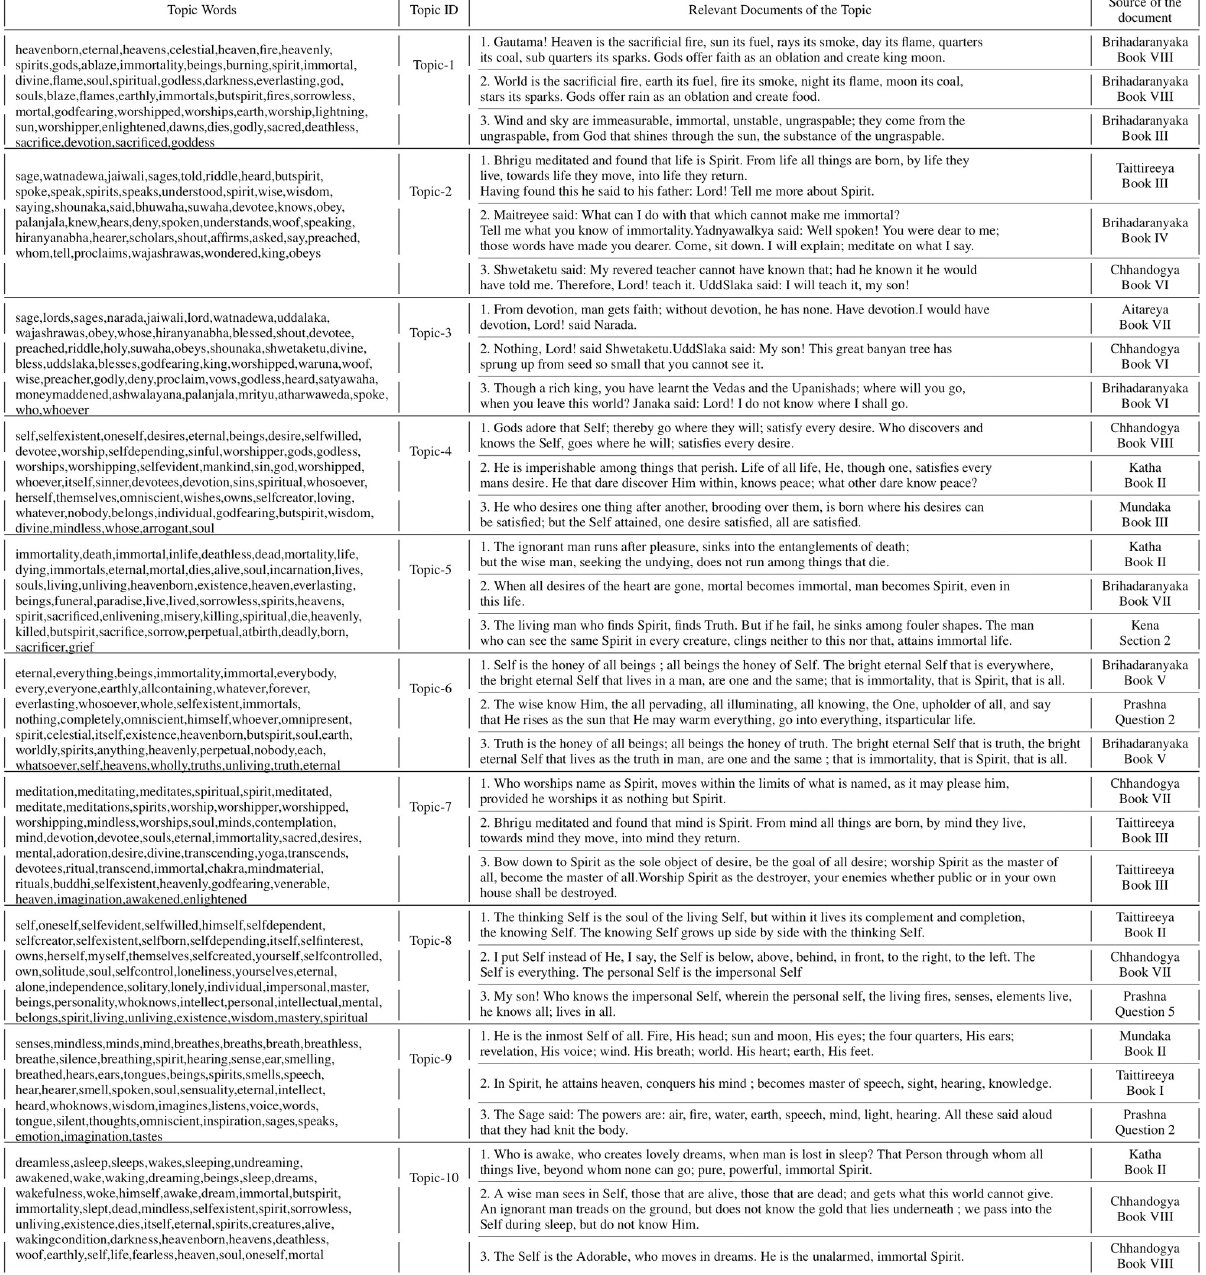
PLOS ONE | https://doi.org/10.1371/journal.pone.0273476 September 1,